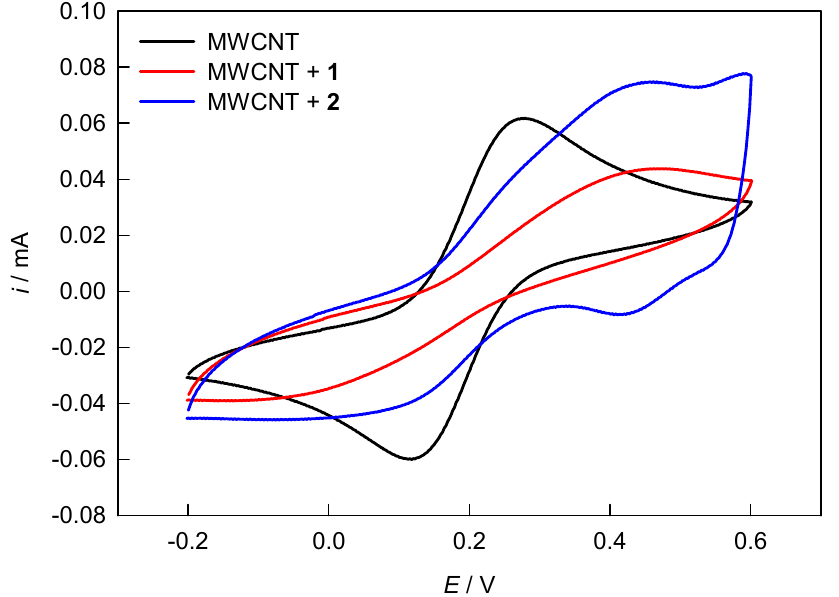
Figure 4. Cyclic voltammograms of the 1 mmol L − 1 [Fe(CN) 6 ] 3 − /4 − redox probe in 0.1 mol L − 1 KNO 3 (pH 7.0) at MWCNT electrode, MWCNT| 1 electrode and MWCNT| 2 electrode recorded with a scan rate of 50 mV s − 1 .